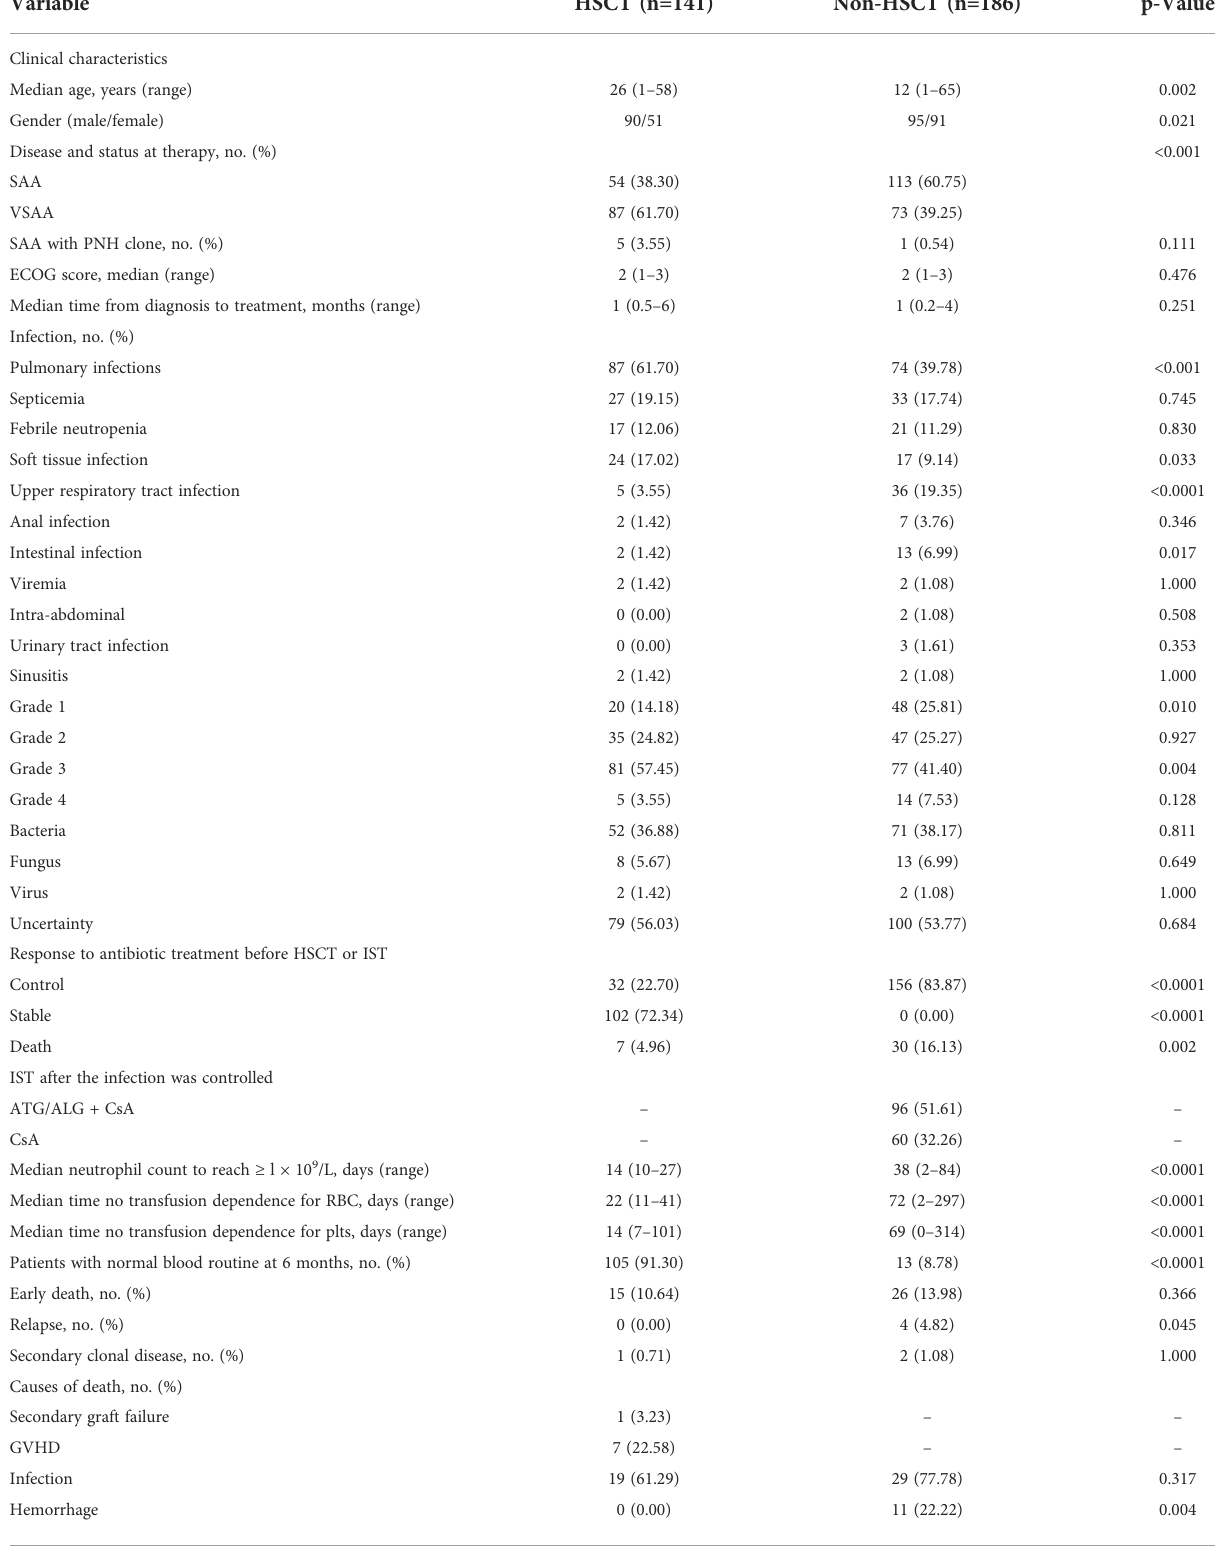
TABLE 1 Characteristics of SAA patients and clinical outcomes after